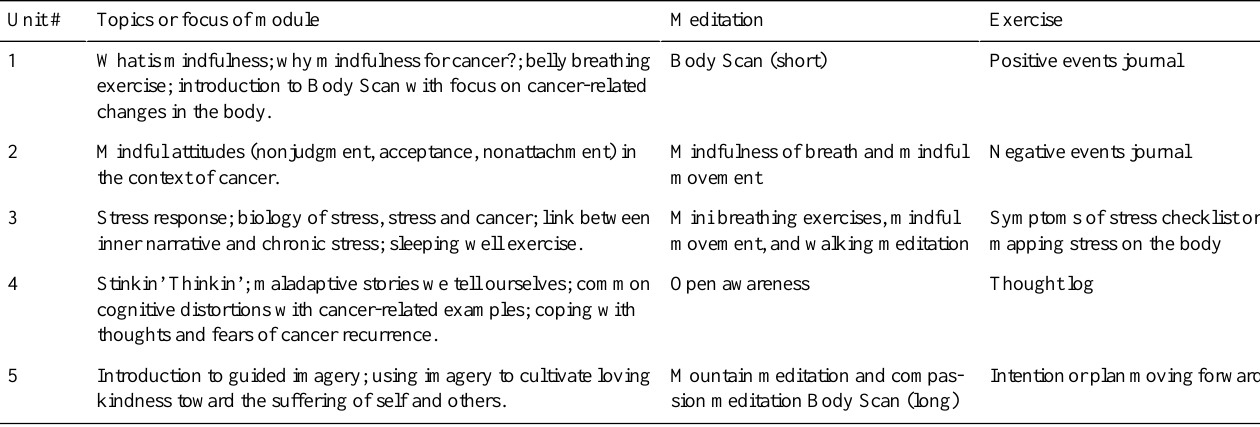
Table 2. App-based mindfulness-based cancer survivorship curriculum. ExerciseMeditationTopics or focus of moduleUnit # exercise; introduction to Body Scan with focus on cancer-related changes in the